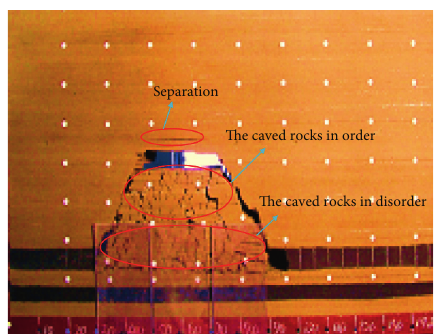
Figure 8: 32.5m advancement.